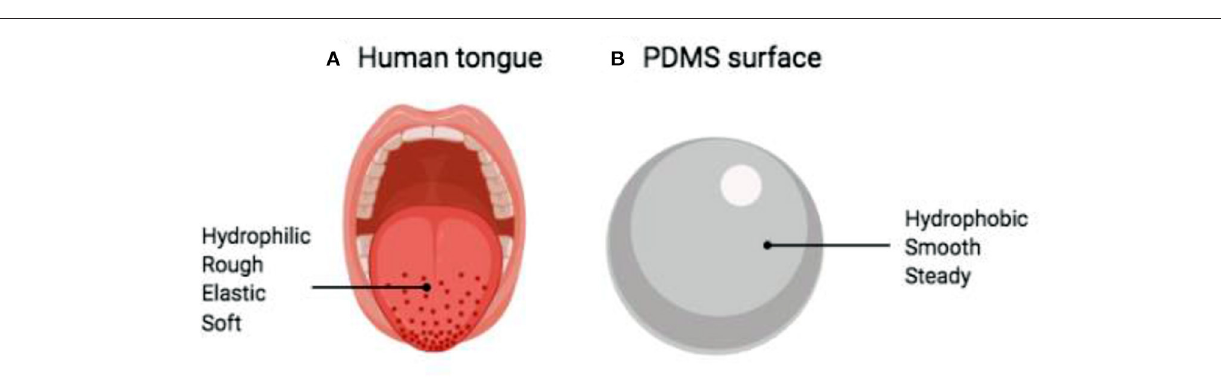
FIGURE 2 | Comparison between (A) human tongue and (B) untreated PDMS surface. PDMS: Polydimethylsiloxane. Figure edited from Rudge et al.